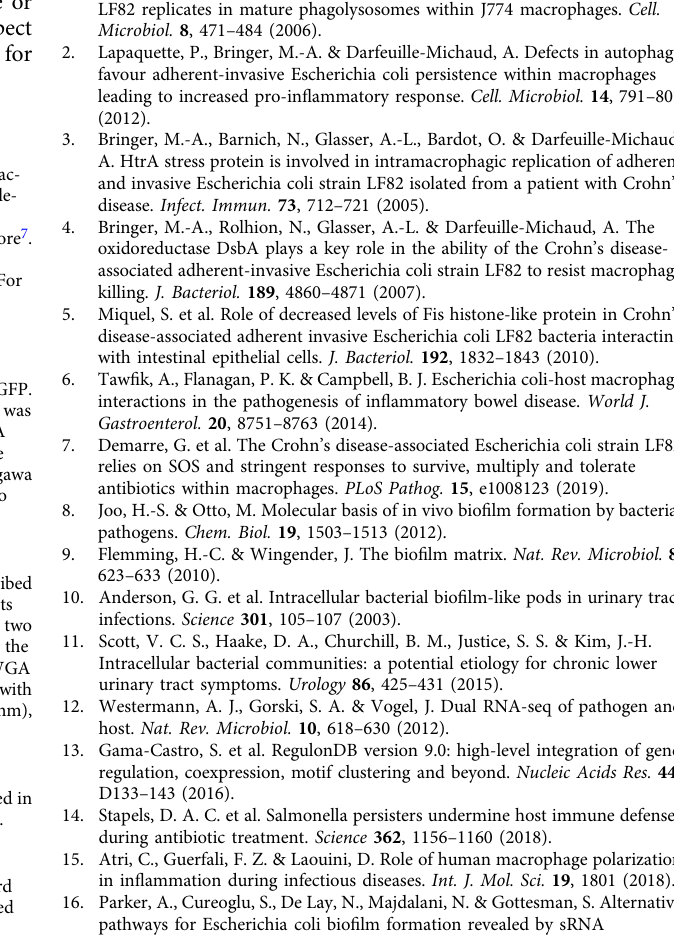
Fig. 6 Exopolysaccharide matrix formation and iron homeostasis are interconnected. a Imaging of the expression of the HPI promoter monitored with an unstable GFP fusion. WT and csgD mutant LF82 – mCherry strains expressing P-HPI-GFP* from a plasmid were imaged. Scale bars are 5 µ m. b Quanti fi cation of the distribution of P-HPI-GFP* fl uorescence in LF82. The GFP fl uorescence intensity of about 1000 m-Cherry objects was analyzed, data are from a representative experiment performed in triplicate. c Quanti fi cation of the distribution of P-HPI-GFP* fl uorescence in the LF82 csgD mutant. d Quanti fi cation of the % of P-HPI-GFP*-positive cells in the WT strain and the glgCAP, adrA, bcsB, qseB , and csgD LF82 mutants. Values are the mean of three replicates, error bars are SD. e Expression data from RNA-seq experiments at 1 and 6 h of P.I. of THP1 macrophages for the genes annotated for their participation in iron homeostasis in LF82. Genes were organized according to their position on the genome. Clusters of genes are delineated by a vertical line. f Expression data from RNA-seq experiments for the genes annotated for their participation in iron homeostasis in humans. g Summary of our results unveiling LF82 ’ s strategy to survive within macrophage. Non-replicating AIEC (red), Replicating AIEC expressing HPI and the bio fi lm pathway (green), bio fi lm matix (blue waves), Nucleus (dark